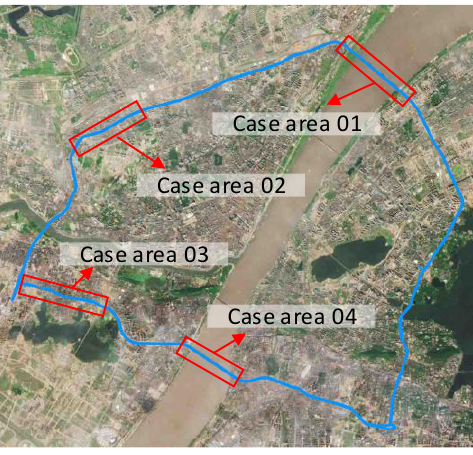
Figure 6. Case area